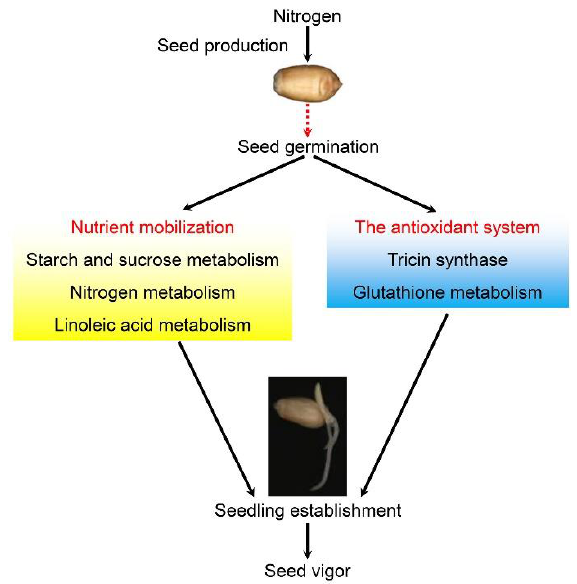
Figure 6. A possible network of nitrogen level during seed production affecting seedling establishment and seed vigor. Red dotted line indicates transition.